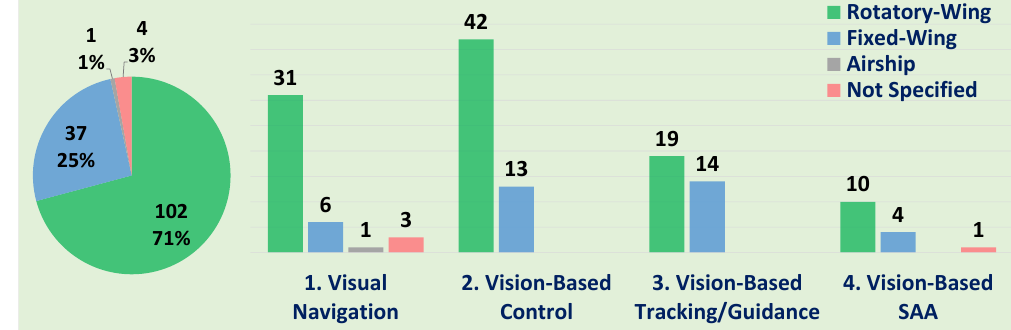
Figure 11. UAV class distribution over the database.